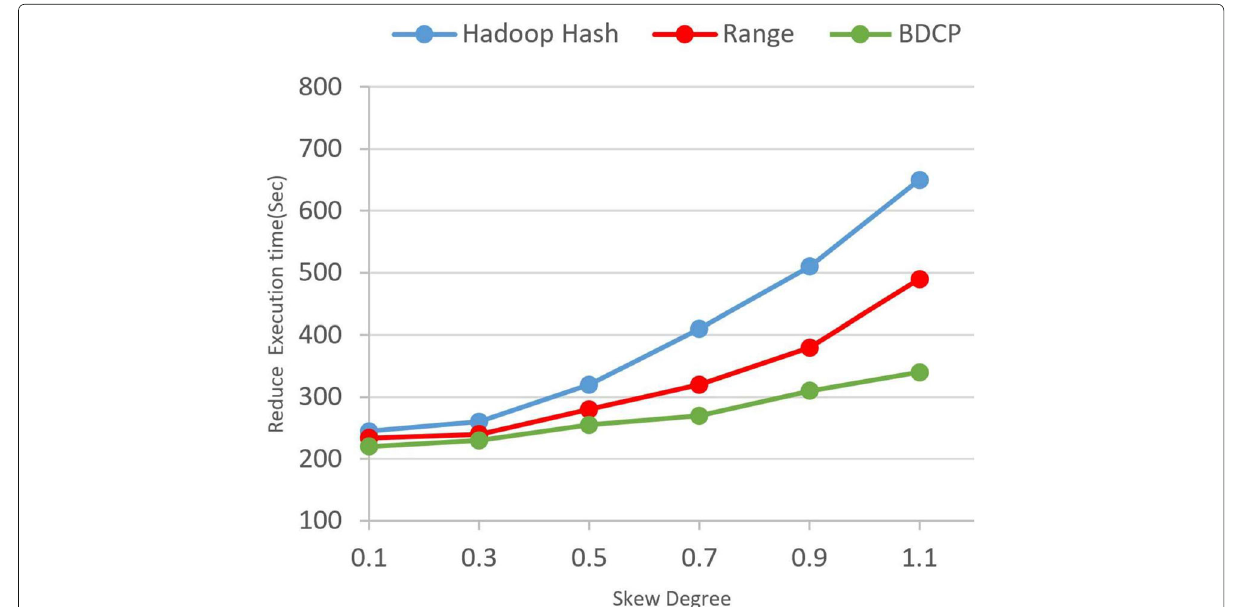
Fig. 16 Sort job on a file of size 6 GB, and 0.1 to 1.1 skew